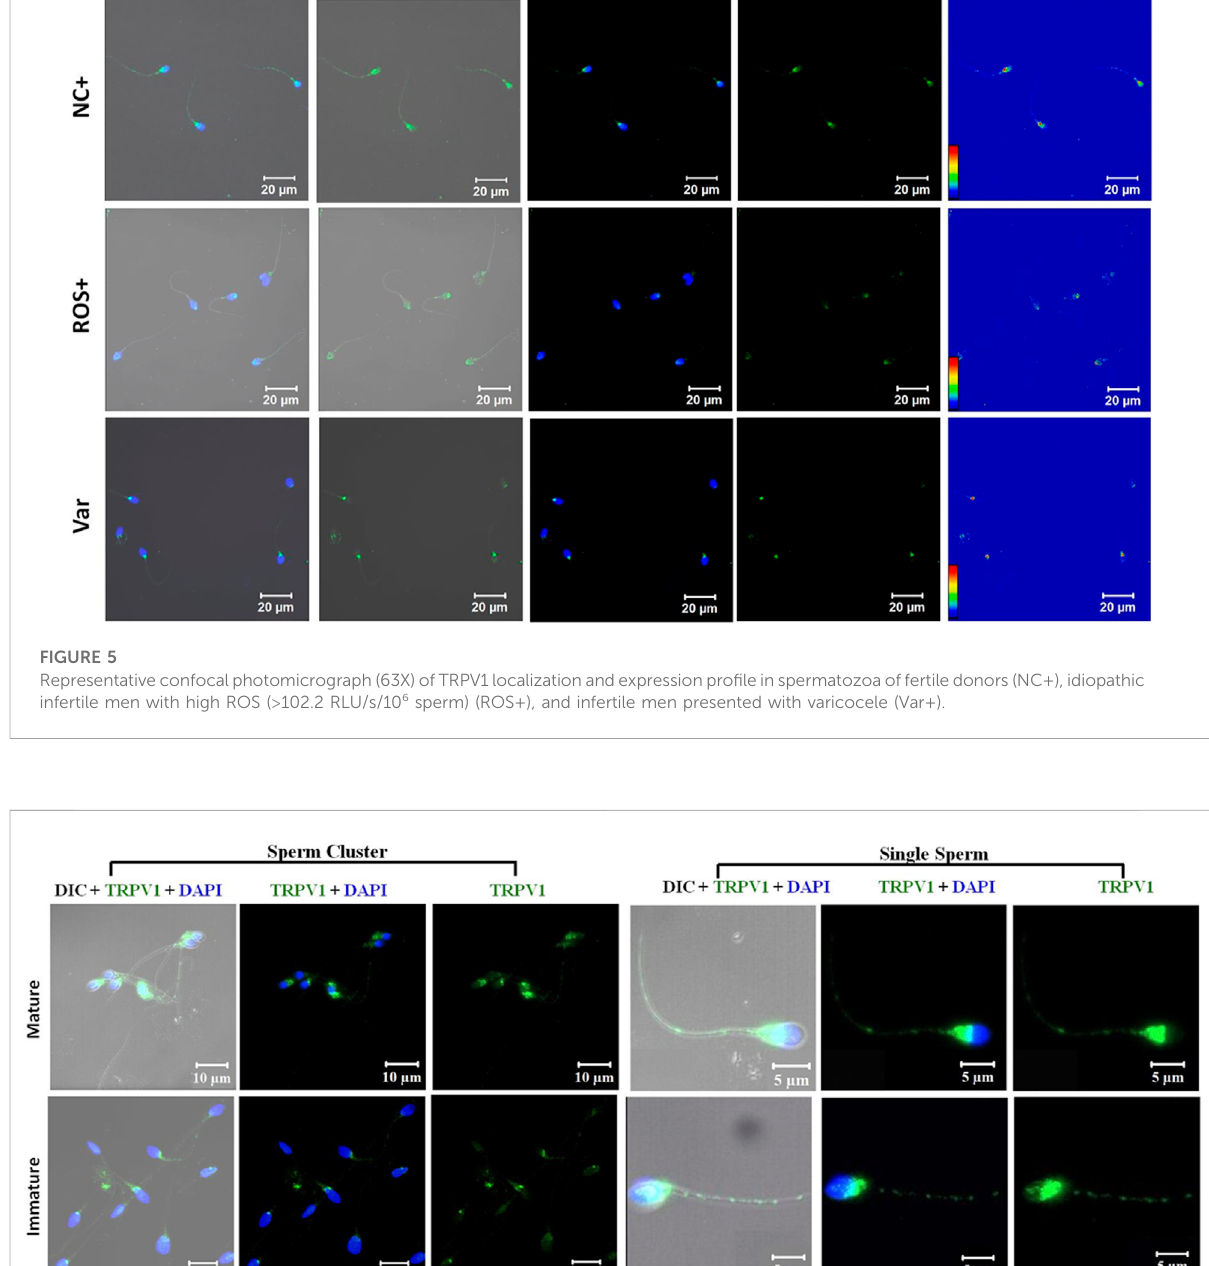
H 2 O 2 , the level of induction was similar to H 2 O 2 alone. iRTX did not affect acrosomal reaction at all, but brought back the acrosomal reaction induced by H 2 O 2 to basal level (Figure 9A).